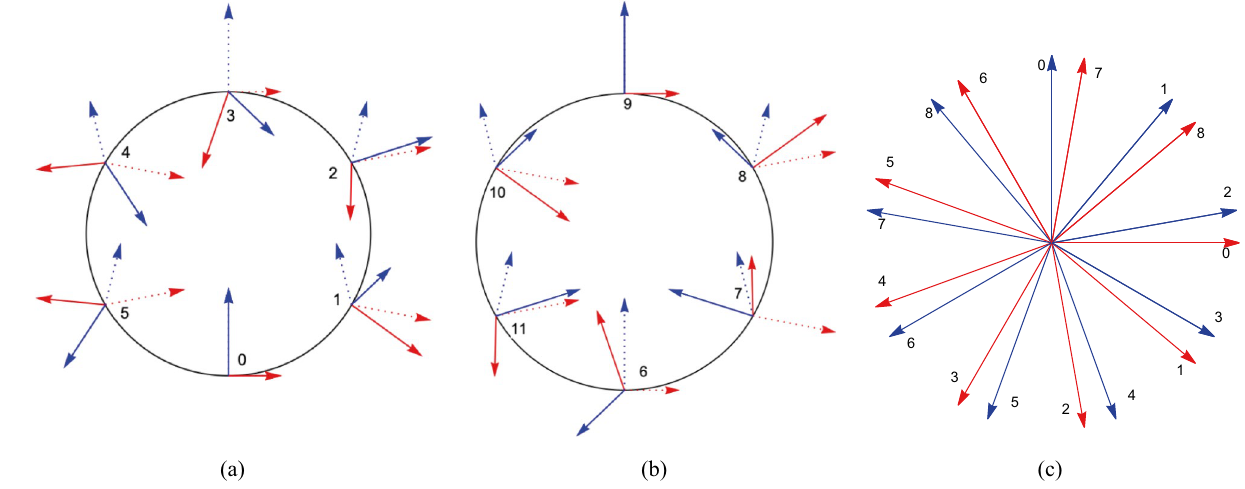
Figure 5. ( a , b ). For a particle in uniform circular motion, the X (red) and Y (blue) axes will make a complicated motion as seen from the lab frame. In the article, we show how to extract a linear rotation, which we identify with Thomas precession, and an additional nonlinear rotation. The solid lines represent the axes of a Fermi– Walker accelerated frame, the dotted lines the axes of a boosted frame, defined by pure Lorentz boosts applied to the lab frame. The length of the axes is constant in the accelerated frame, but varies in the lab frame due to 4 c / 5 , thus γ 5 / 3 . The axes were chosen to coincide with the lab axes Lorentz contraction. The speed is v = = nT / 6 , with T the period R 0 , when the particle is at 0, at t . The position of the axes is shown at times t = = { − } 0, 1, . . . , 5 and ( b ) n 6, 7, . . . , 11 . ( c ) In the frame defined by the dotted axes, the in the lab frame, for ( a ) n = = 1 )ω , hence a period γ(γ boosted frame, the solid axes appear to be purely rotating, with a frequency ω ′ = − T 9 T / 10 . Due to the time dilation, in the boosted frame the axes of the FW frame will appear as shown in ′ = nT / 10 nT 9 the subfigure at times t ′ ′ / = =